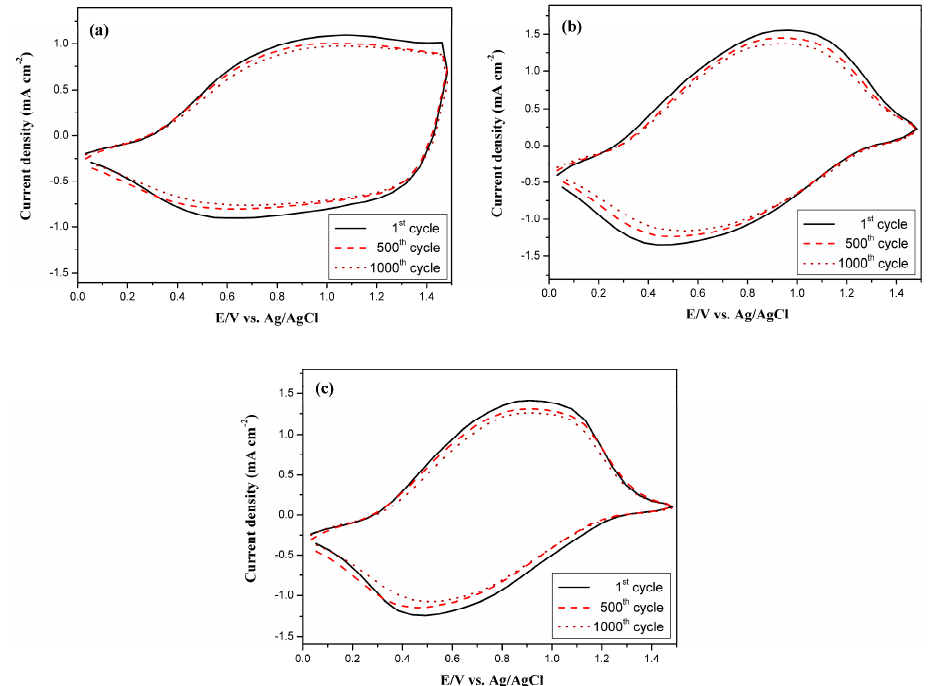
Figure 10. Cyclic voltammograms of ( a ) PtCz/PEDOT; ( b ) PtCz/PProDOT-Me 2 ; and ( c ) PtCz/PProDOT-Et 2 ECDs as a function of repeated with a scan rate of 500 mV ∙ s − 1 between 1 and 1000 cycles. The working electrode is PtCz film-coated ITO glass